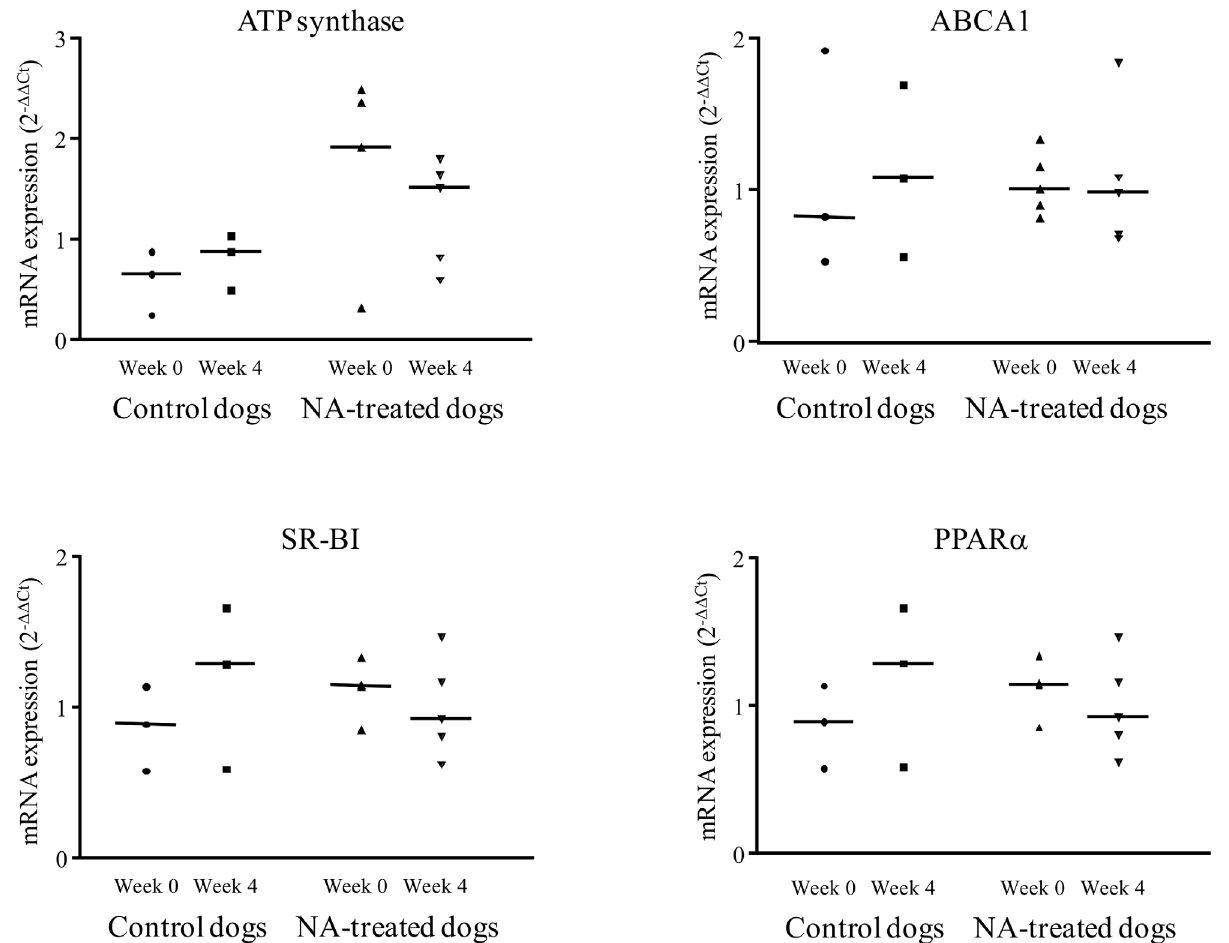
Fig 2. Relative expression of PPAR α , SR-BI, ABCA1 and ATP synthase mRNA in liver of NA treated dogs, before (week 0) and after the end of the 4 weeks treatment (week 4). (PPAR α : peroxisome proliferator-activated receptor α , ABCA1: ATP binding cassette A1, SR-BI: scavenger receptor class B type I), n =